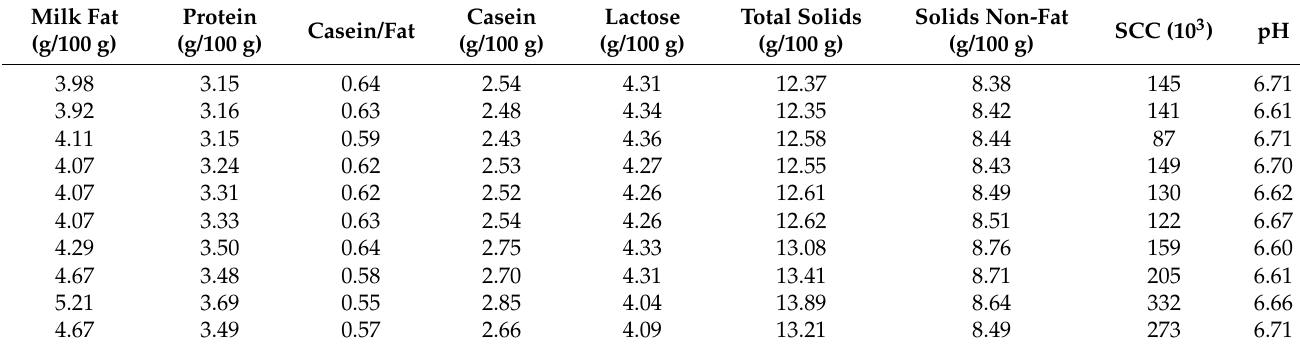
Table 1. Physicochemical composition of cheese milk before standardization ( n =